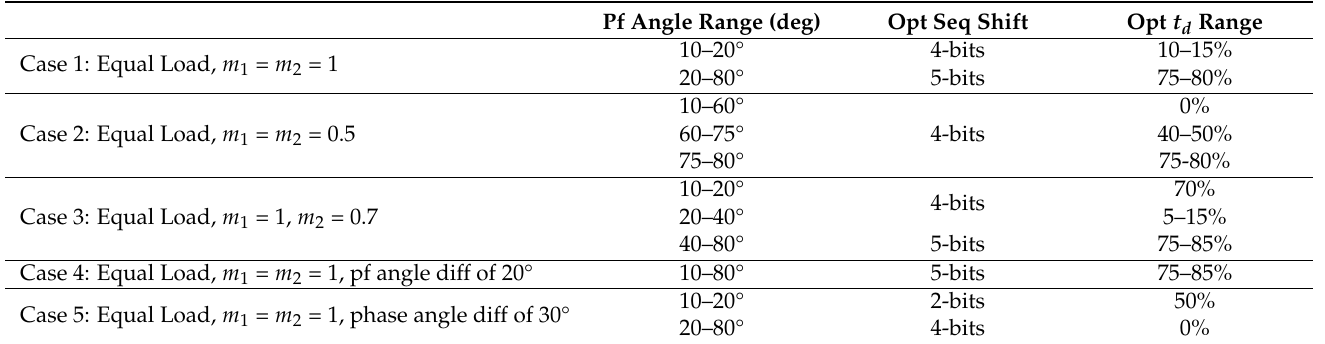
Table 4. Sub-optimal approximations for seq+time interleaving for cases presented in Figures 9–13. Pf Angle Range (deg) Opt Seq Shift Opt t d